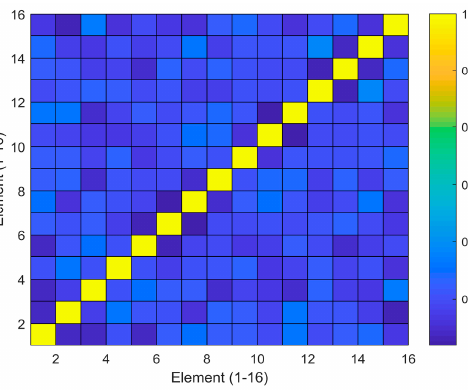
Figure 22. Noise correlation coefficients.